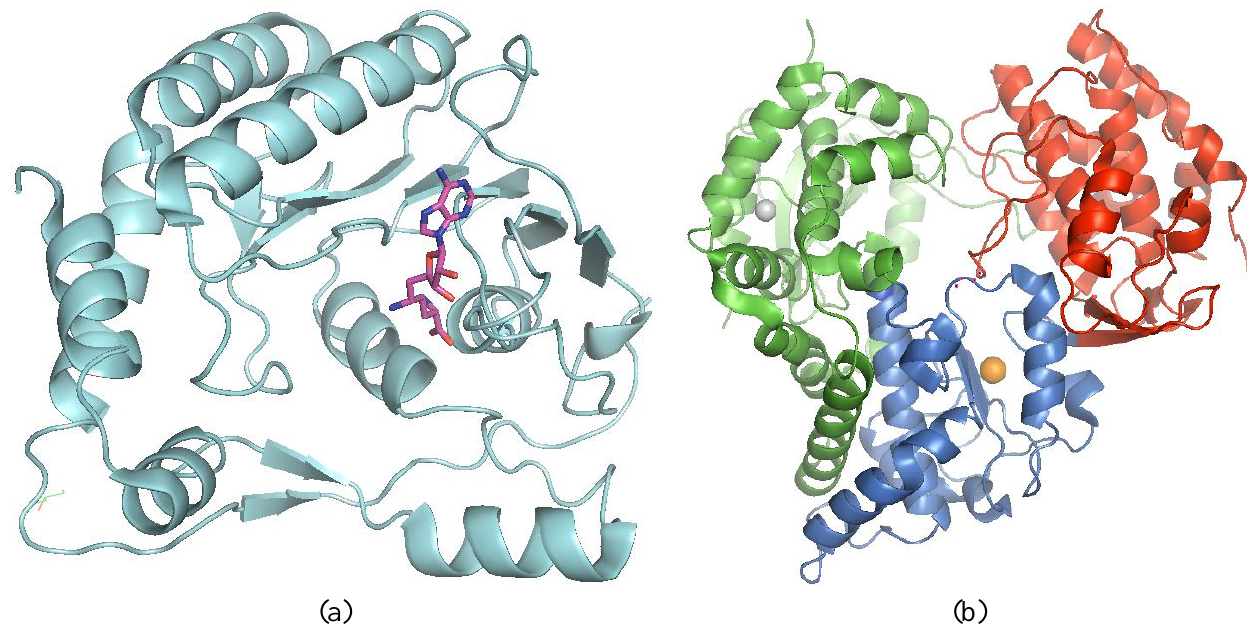
Figure 2. Crystal structures of West Nile Virus (WNV) NS5 MTase and RdRp domains depicted in cartoon representation. (a) WNV MTase (light blue) in complex with sinefugin (pink in stick representation; PDB code 3LKZ). Sinefungin inhibits Flavivirus MTase N7 and 2’- O activities by competitively binding to the enzyme catalytic pocket [121,128]; ( b ) WNV NS5 RdRp domain (blue) bound with Zn (grey sphere) and Mg 2+ (orange sphere) coordinated by Asp536 and 669 (not labeled) [139,143]. Thumb, fingers, and palm subdomains are indicated in red, green and blue (PDB code